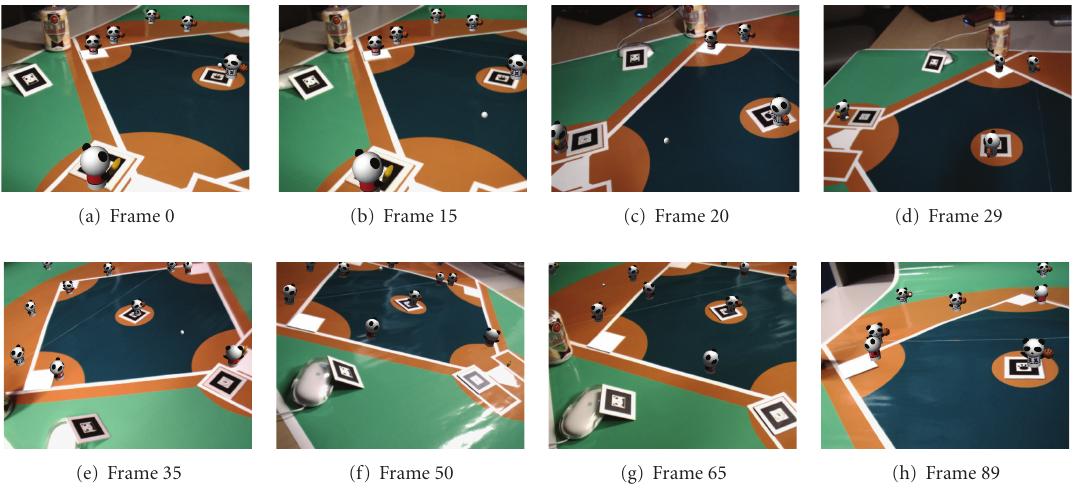
Figure 10: Example of play: 4th batter of team RED sends a hit to left with the bases loaded and scores a goal.